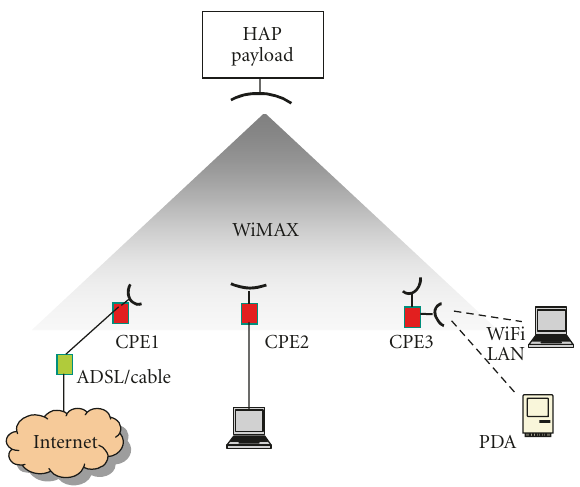
Figure 1: Typical WiMAX-from-HAP trials scenario.